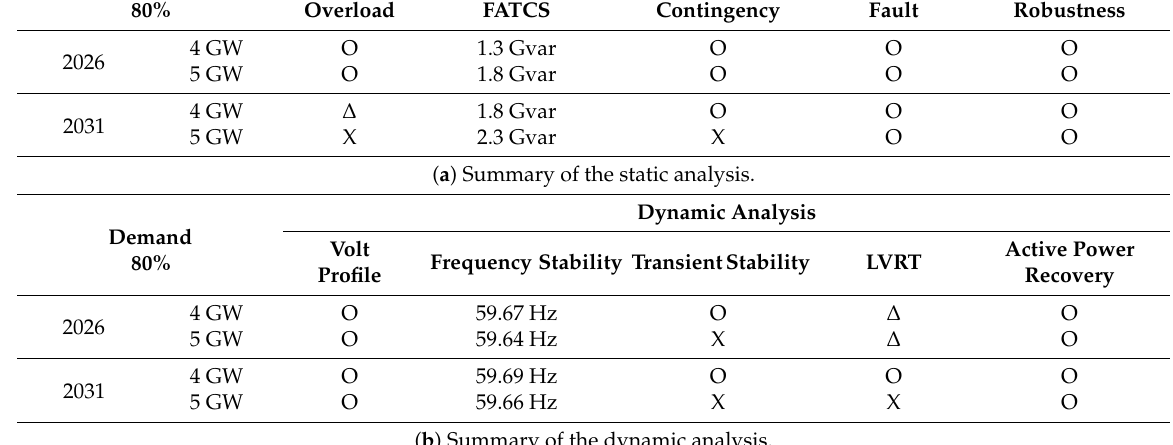
Table 14. Summary of static and dynamic analyses before the reinforcement plan. Static Analysis FATCS Contingency